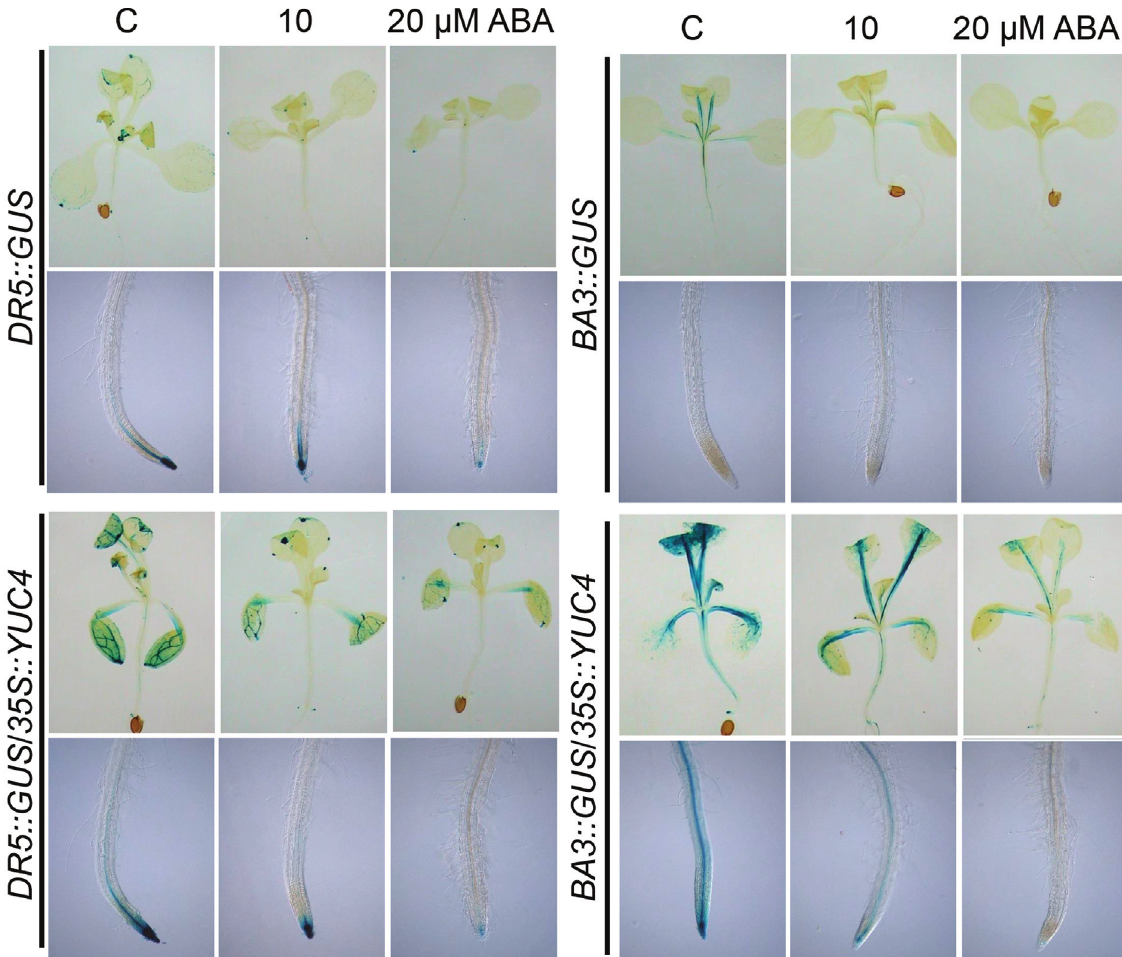
Figure 7 - ABA impairs auxin-inducible gene expression in shoots and roots. DR5::GUS and BA3::GUS gene expression in WT and 35S::YUC4 seed- lings germinated and grown for 5 d in agar solidified 0.2x MS medium, then transferred for 5 additional days to fresh medium supplemented with the sol- vent, 10 or 20 (cid:2) M ABA. Seedlings were stained for GUS activity and cleared for microscopical analysis. Photographs show representative shoots and roots from at least 15 stained plants. The experiment was repeated three times with similar